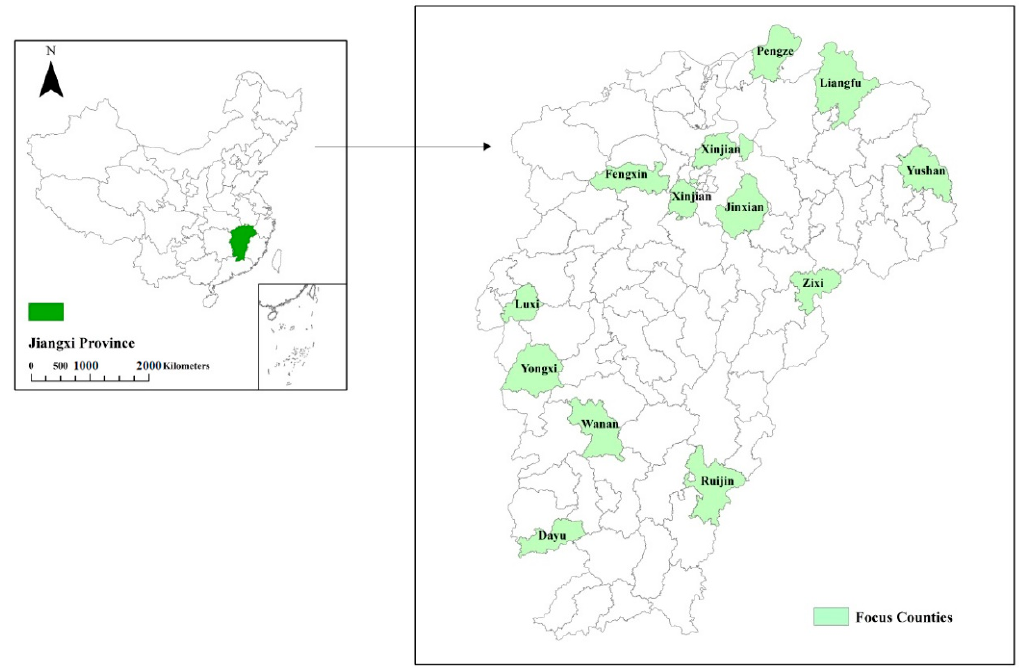
Figure 2. Study area in Jiangxi Province.